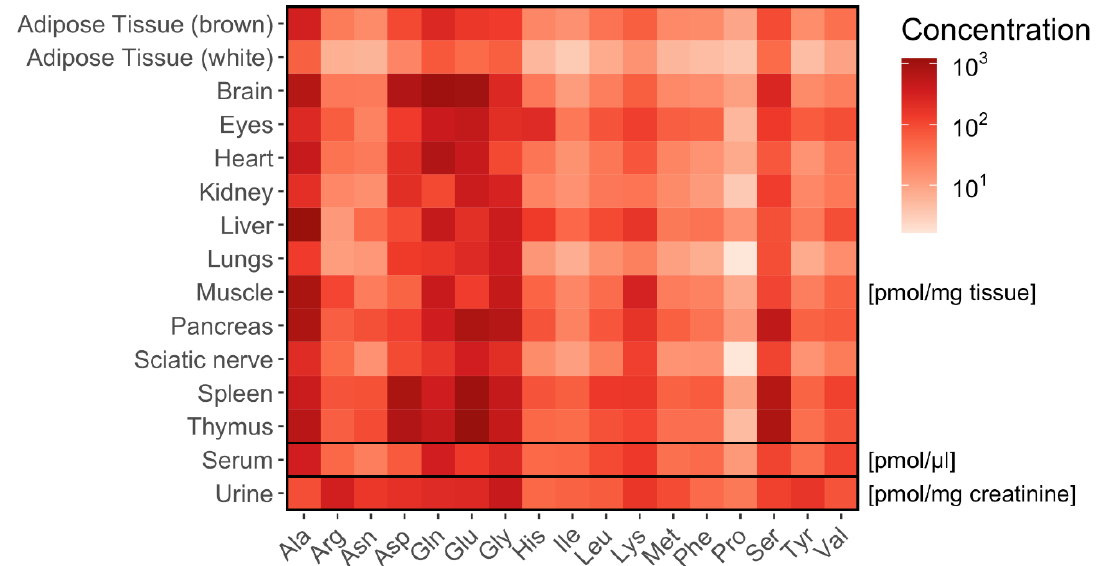
Figure 7. Distribution of amino acids in murine tissues and biofluids. Heat map showing the concentrations for 17 amino acids concentration ( n = 6) in murine tissues (adipose tissue, brain, eyes, heart, kidney, liver, lungs, muscle, nervus ischiadicus, pancreas, spleen and thymus) and biofluids (serum, urine). Mean values are given in pmol/mg tissue ( n = 6). In serum, the concentrations are given in pmol/µL and in urine in pmol/mg creatinine ( n = 5).